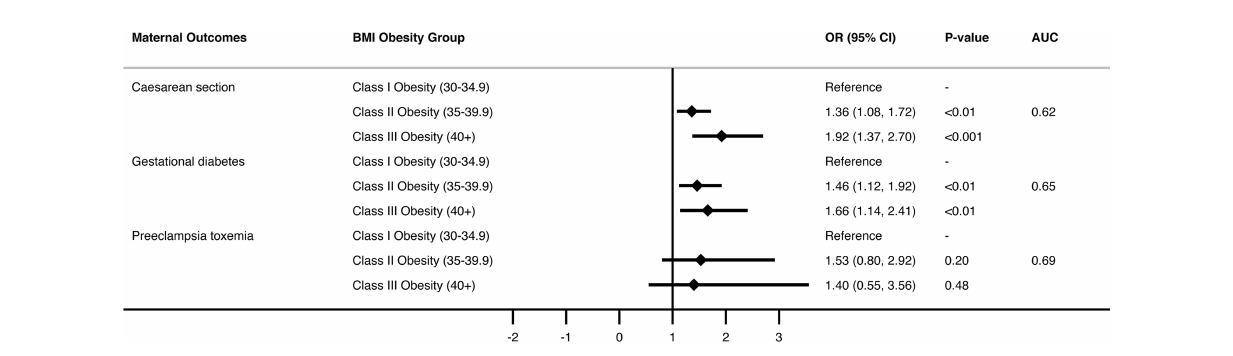
FIGURE 1 | Multivariate logistic regression model of three maternal outcomes by BMI group.